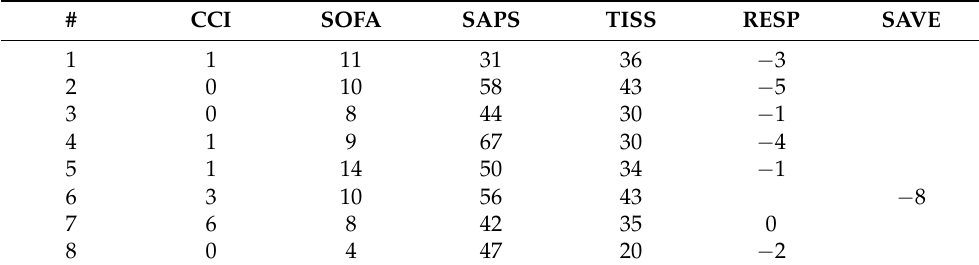
Table 2. Individual outcome prediction and disease severity